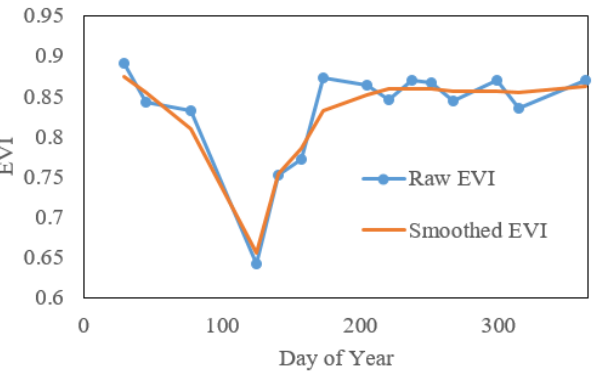
Figure 4. An example of raw and smoothed EVI time series in Puerto Rico.